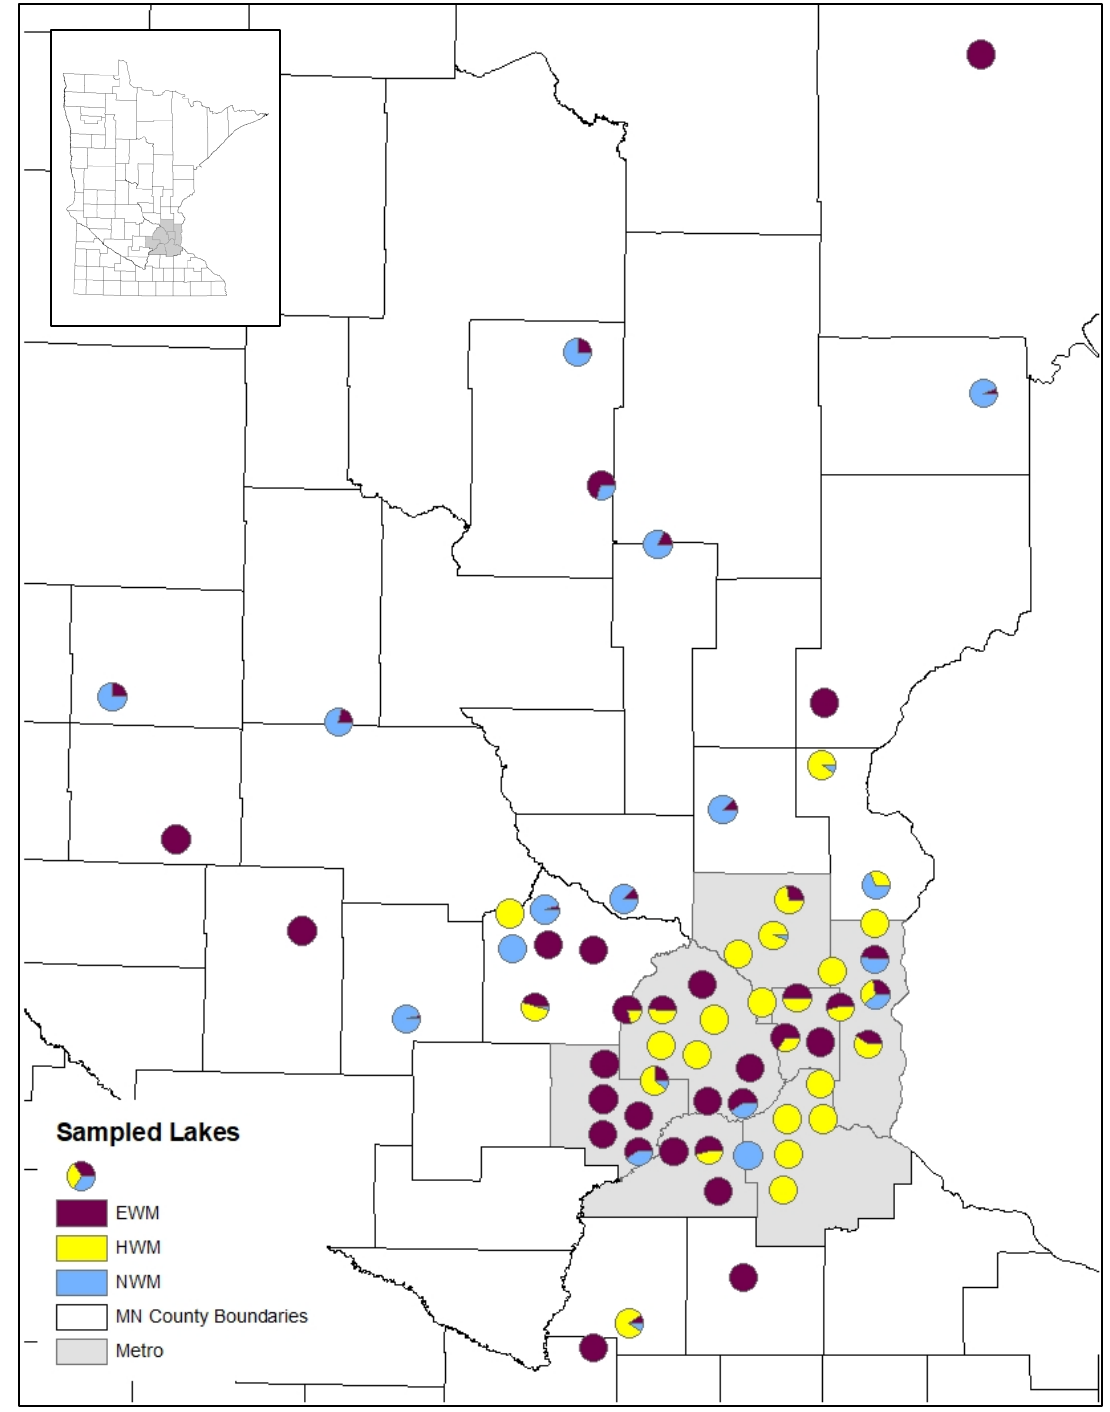
Figure 1. Statewide occurrence of Eurasian (EWM, purple), hybrid (HWM, yellow), and northern (NWM, blue) watermilfoil proportions in sampled lakes. Metro area counties are shaded in gray. Table 1. Number of lakes with various combinations of watermilfoil taxa identified (EWM = Eurasian watermilfoil, HWM = hybrid watermilfoil, NWM = northern watermilfoil). Lake counts are grouped based on region (Greater Minnesota and Metro area).